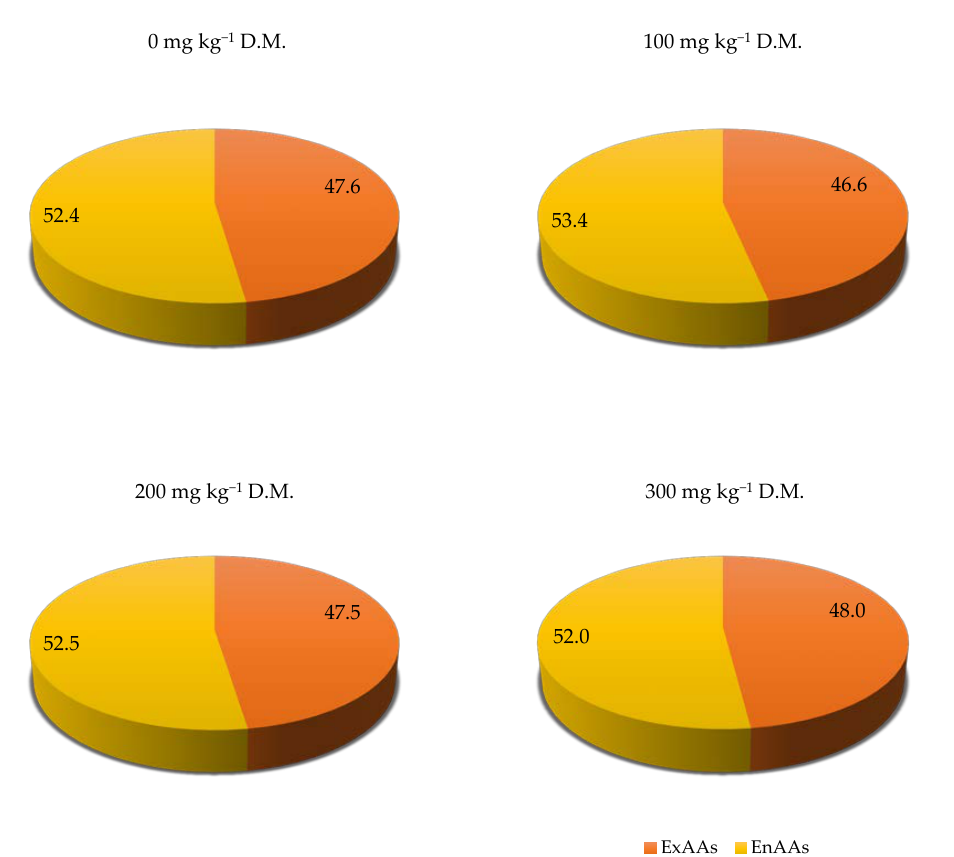
Figure 1. Contribution of ExAAs and EnAAs to TotAAs in the above-ground parts of winter oilseed rape ( Brassica napus L.) depending on soil contamination with fluorine, in %.